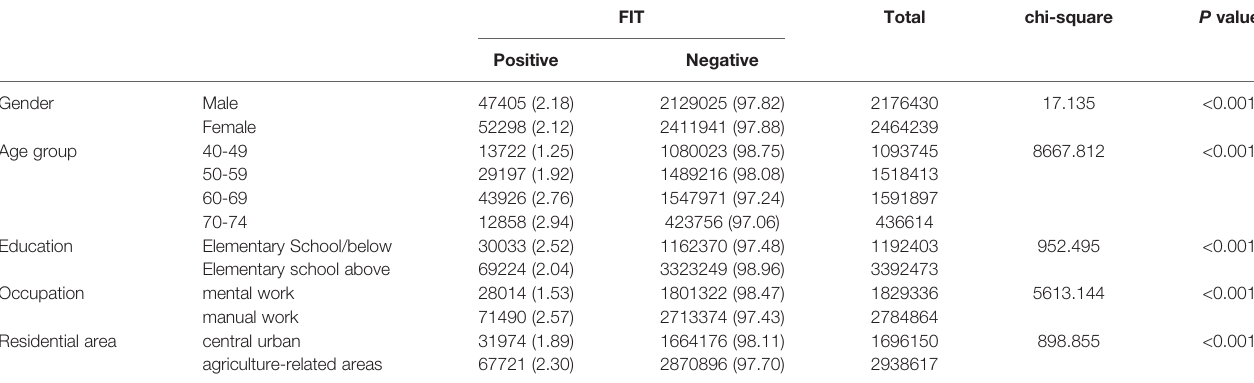
TABLE 3 | Comparison of positive FIT for different CRC screening population subgroups (2012-2020), (n,